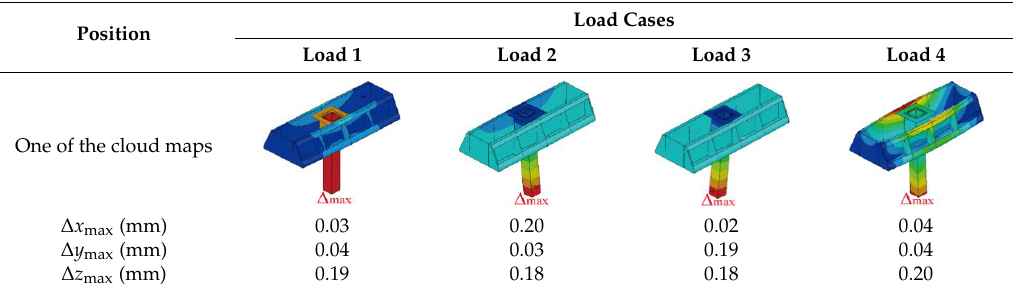
Table 7. Maximum displacements of the milling head after design optimization of the framework.